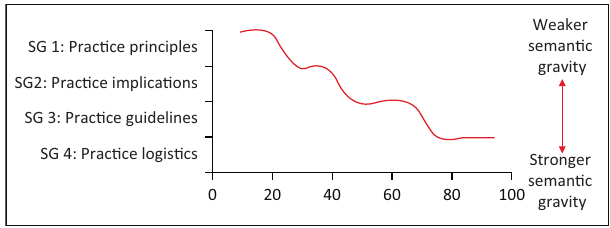
FIGURE 1: An ideal semantic gravity profile for assessment policy.